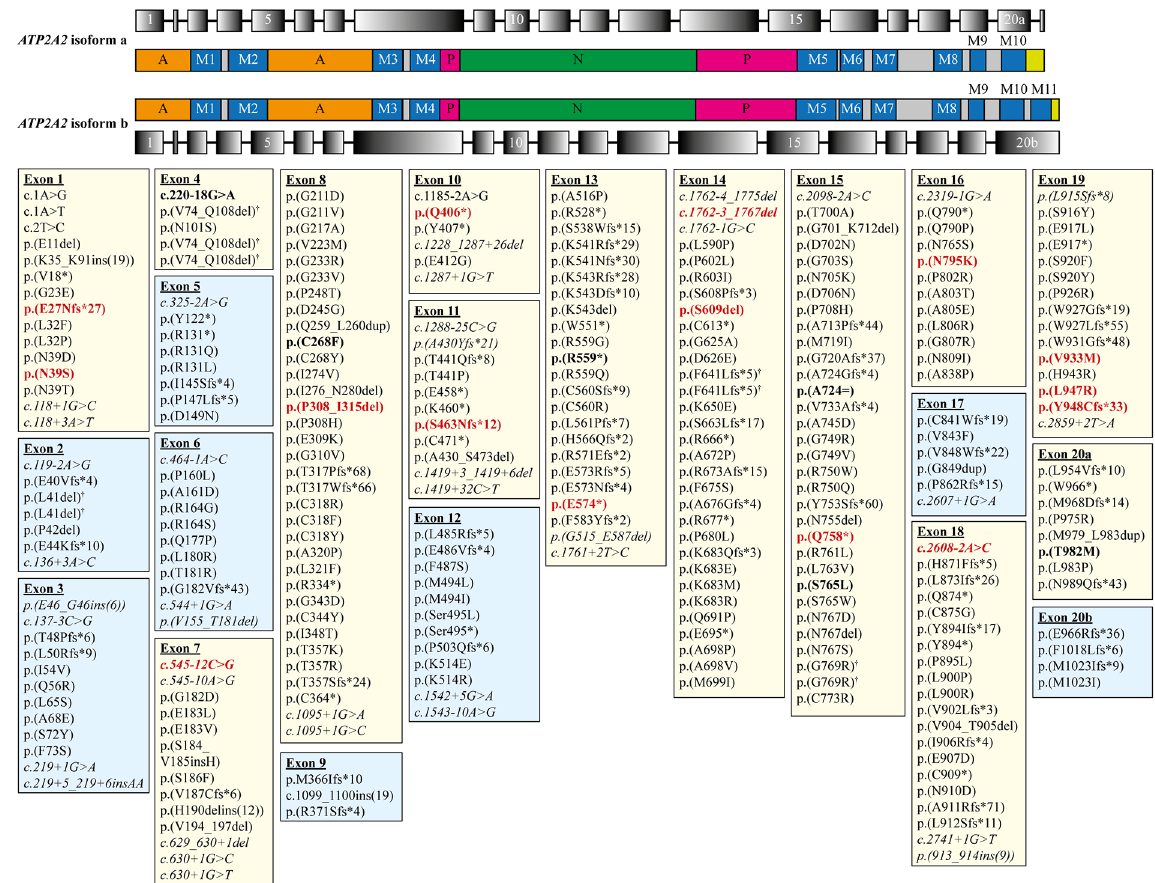
Fig 1. The location of all published/reported ATP2A2 variants (in both isoforms) and variants discovered in the current study associated with Darier disease. ATP2A2 isoform a consists of 21 exons (top row), which encodesfor 10 transmembrane domains(M1 –M10, second row), and it is expressedin cardiomyocytes and slow-tiwtch skeletal muscles. The ATP2A2 isoform b consists of 20 exons (fourth row), which encodesfor 11 transmembrane domains(M1 –M11, third row) and it is expressedin most tissue types [3]. Both isoforms have an actuator domain(A, orangeboxes), phosphorylation domain(P, pink boxes), nucleotide bindingdomain(N, green boxes) and C-terminus (lime green boxes). All geneticvariants are listed in either pale yellow (exon with variants discoveredin this study) or blue boxes (exon with no variants from this study). Novel geneticvariants found in this study are in bold and coloured red. Variants that were discoveredin this study but were not novel are in bold only. Intronic variants are in italics. † indicates ATP2A2 variants with different geneticchanges,but resulted in the same amino acid change.